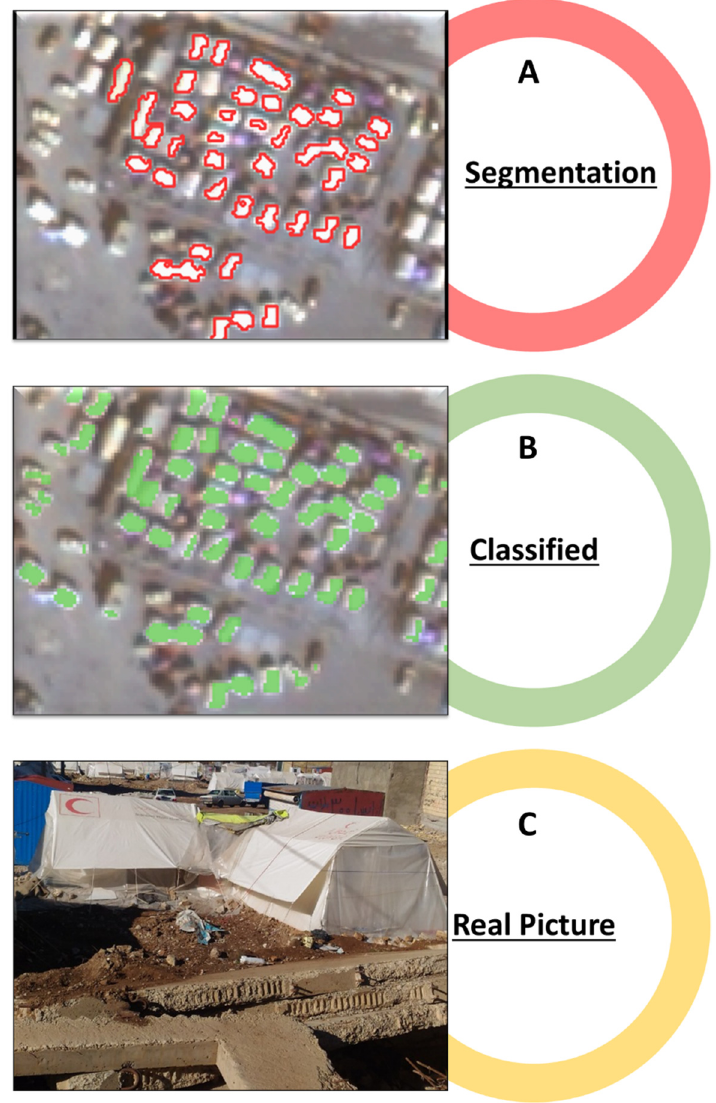
Figure 11. Condition of distributed tents for temporary settlement of people. ( A ): Image segmentation into objects as tents, ( B ): classified objects as tents; and ( C ): photo taken by the authors at the earthquake site. Table 5. Formulation of required resources based on Sphere, 2004 and Bam earthquake report esti- mation [80].